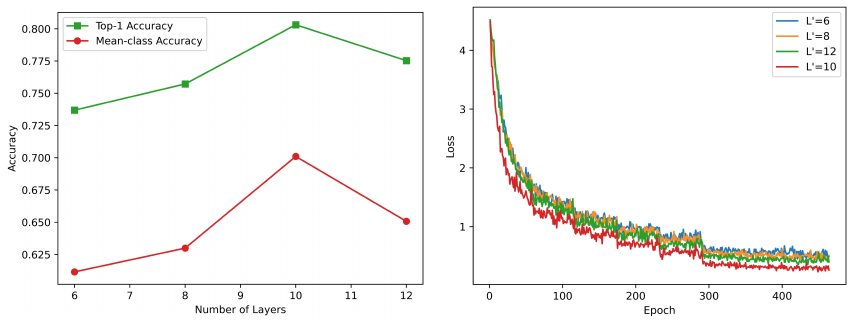
Figure 10. The performance of skeleton stream on FineGym99, while the number of layers is changing ( left ). The loss of the different layers during the training ( right ).